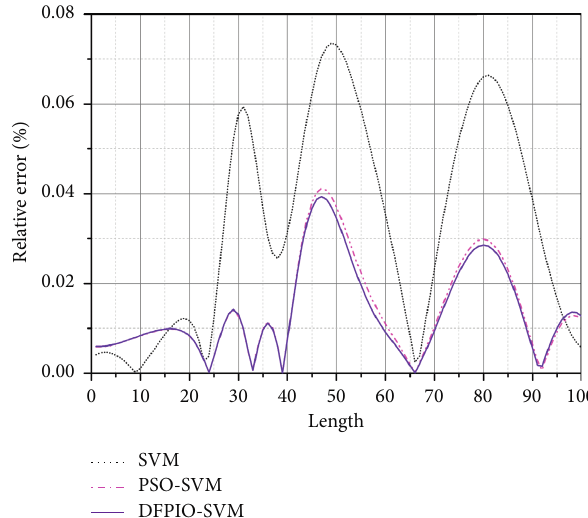
Figure 5: The prediction error curves of three methods for the Mackey–Glass time